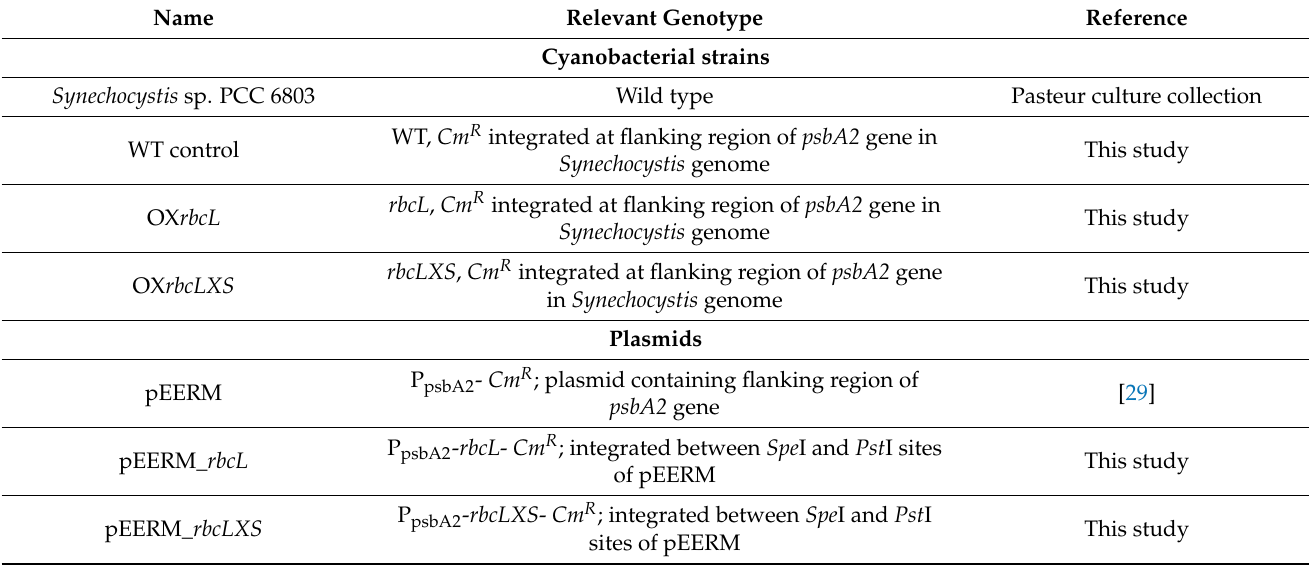
Table 1. Strains and plasmids used in this